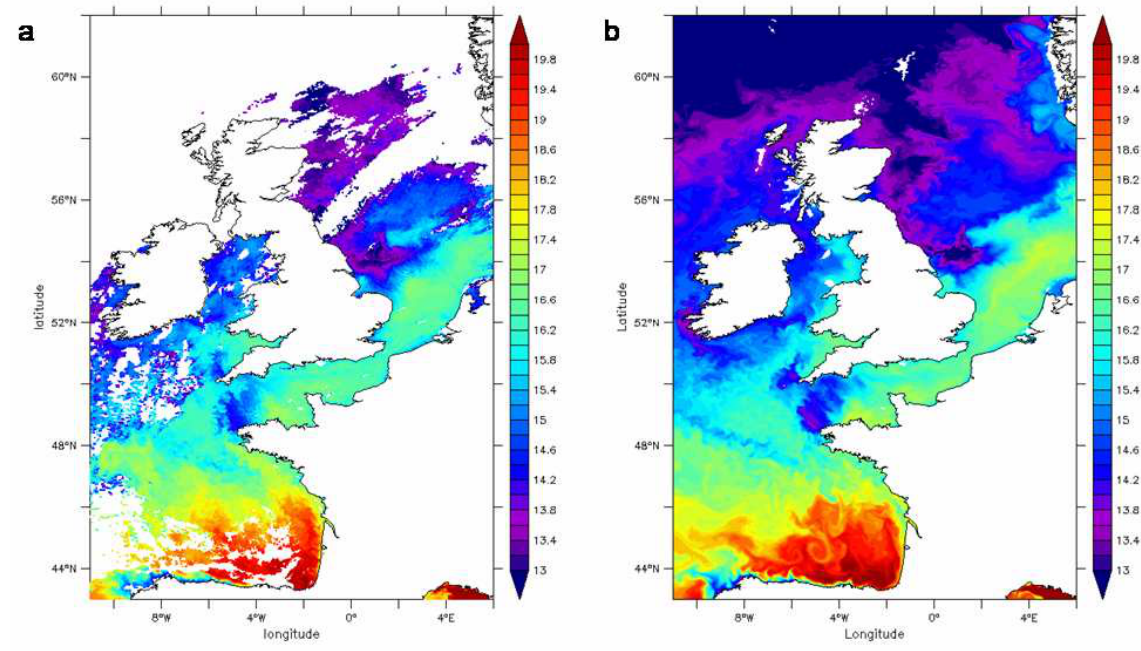
Figure 11: Sea surface temperature (°C) from MODIS data (a) and from the model (b) on Fig. 11. Sea surface temperature ( ◦ C) from MODIS data (a) and from the model (b) on 27 September September 27 th 2008.